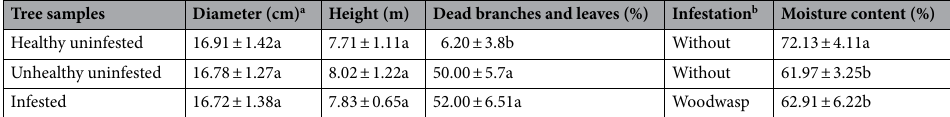
Table 5. Selection of tree samples. a Diameter: The diameter of 2 m above ground from each tree. b Infestation: Whether insect infected the tree samples before